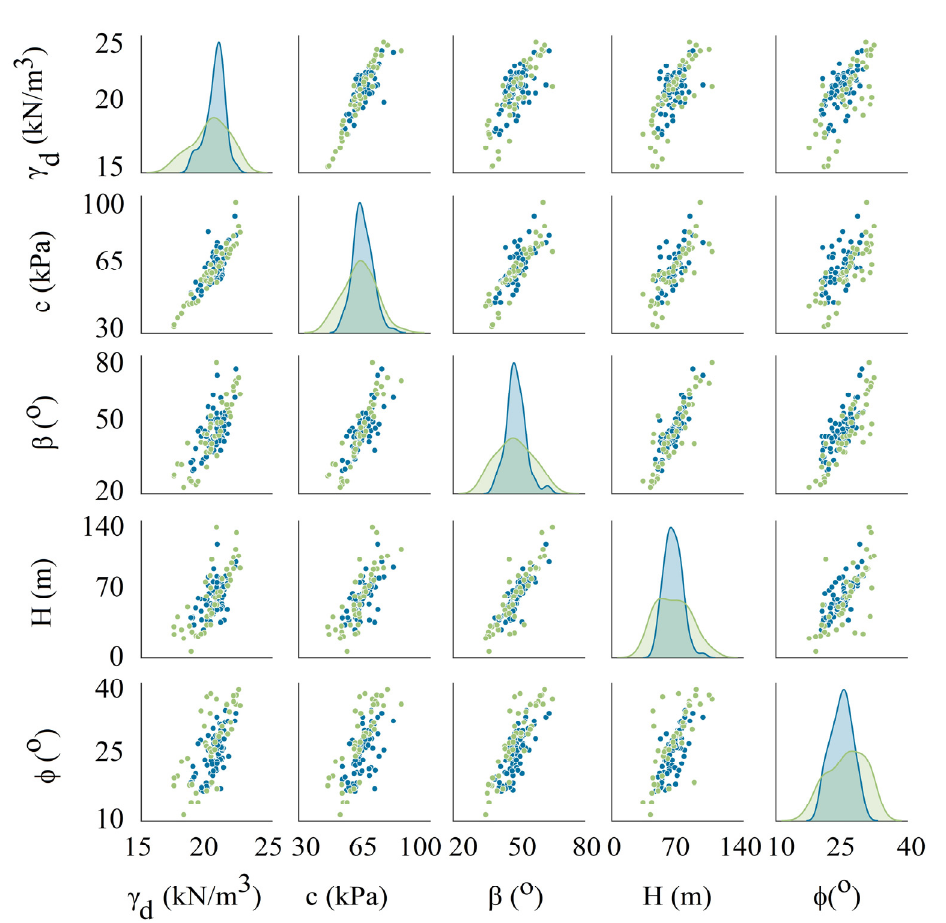
Figure 2. Results of the correlation analysis of the index parameters (green: stable; blue: unstable).